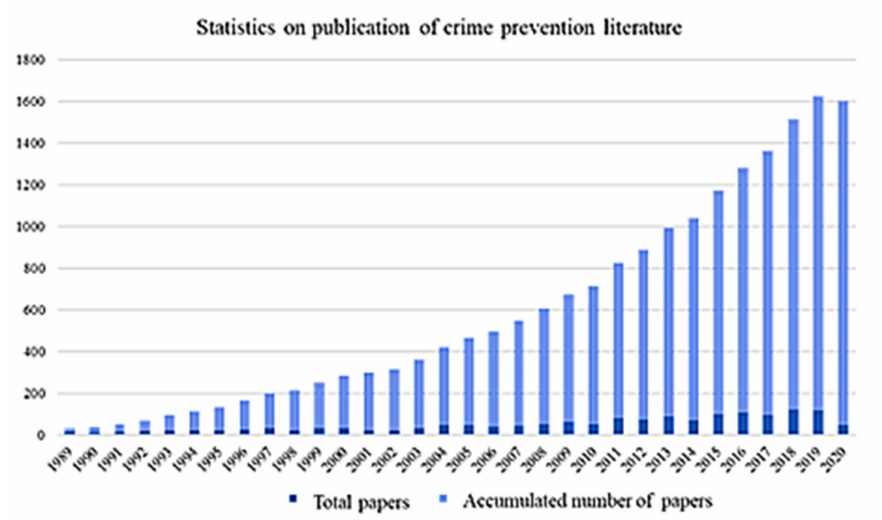
Figure 2. Cumulative papers on crime prevention. Title: Statistics on publication of crime prevention literature. Bottom left text: number of studies published annually. Bottom right text: total number of studies